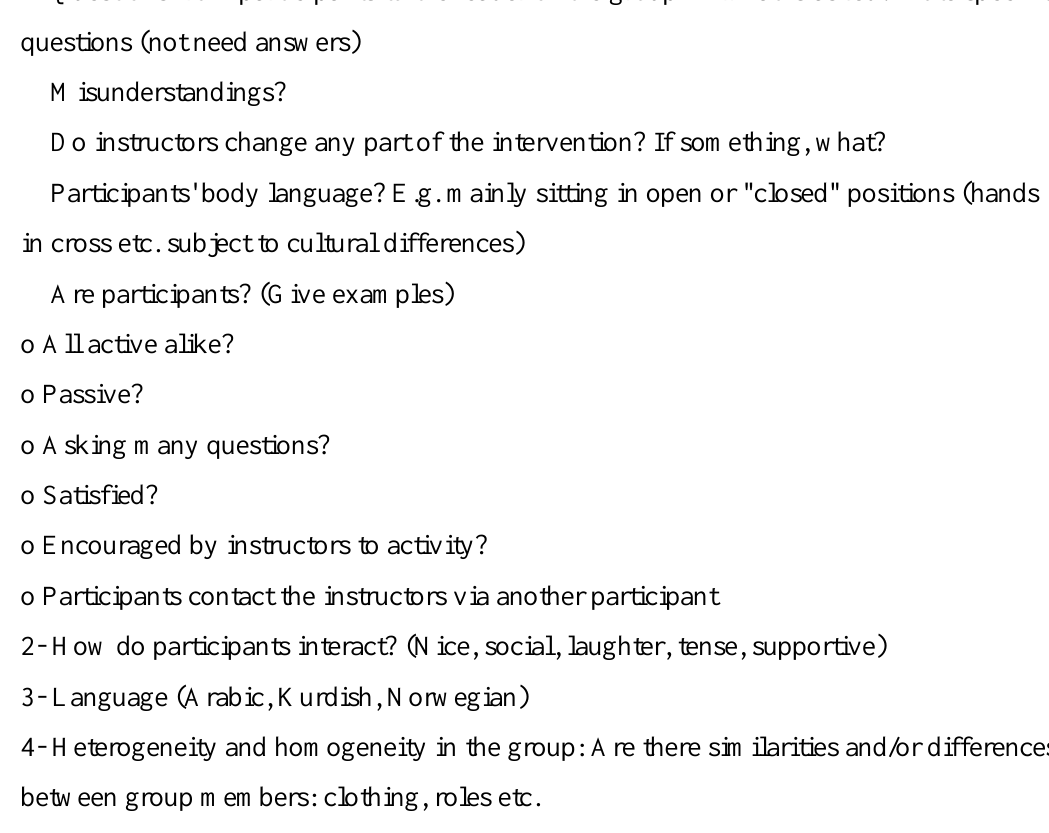
Figure A1. Embedded Process